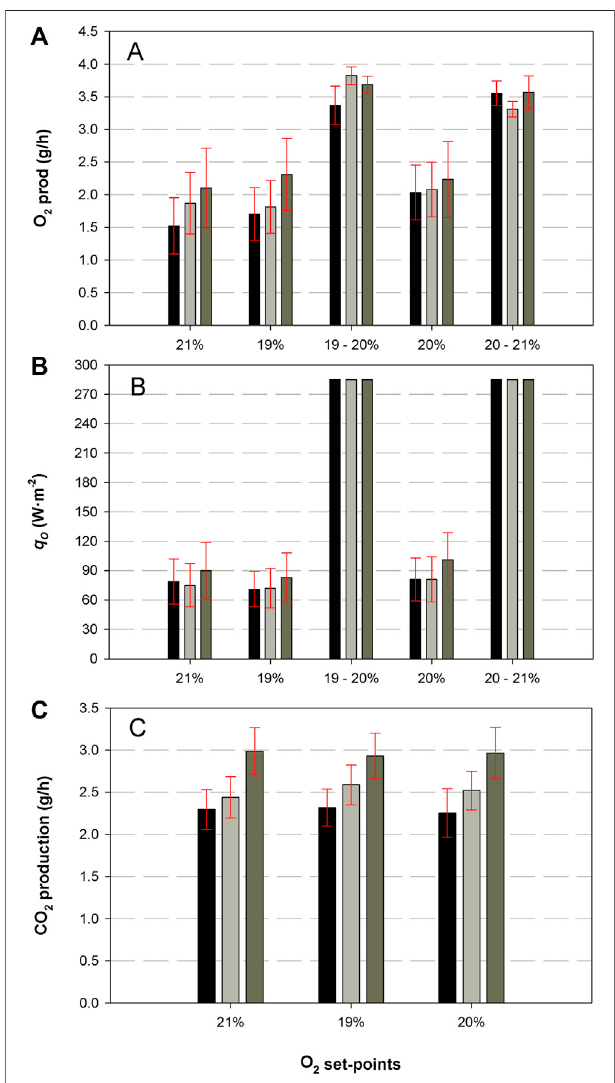
FIGURE 7 | Results for oxygen production (A) and light irradiance (B) in the PBR during the integration with the crew compartment. Carbon dioxide production by the crew compartment are presented in (C) . These values are presented for each O 2 % set-point concentration in the animal isolator. Black, grey and brown columns correspond to the fi rst, second and third group of rats